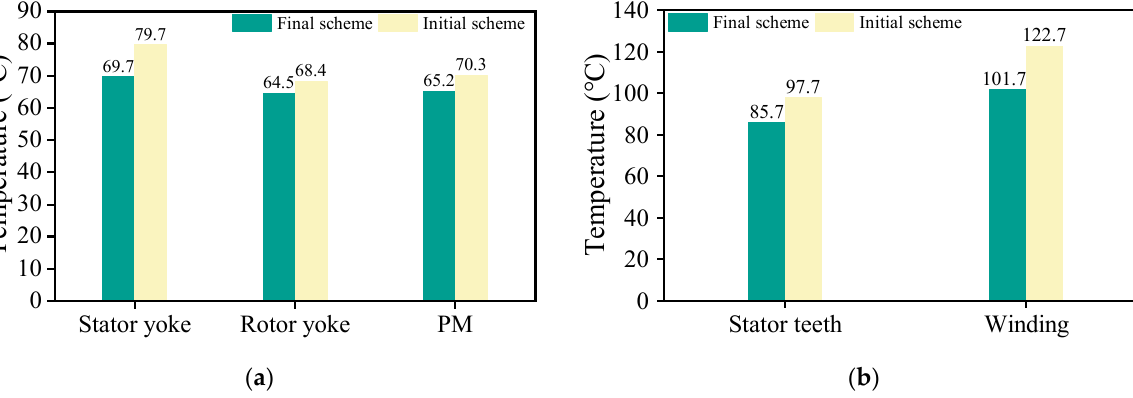
Figure 21. The temperature comparison between final scheme and initial scheme: ( a ) temperature comparisons for stator yoke, rotor yoke, and PM; ( b ) temperature comparisons for stator teeth and winding.